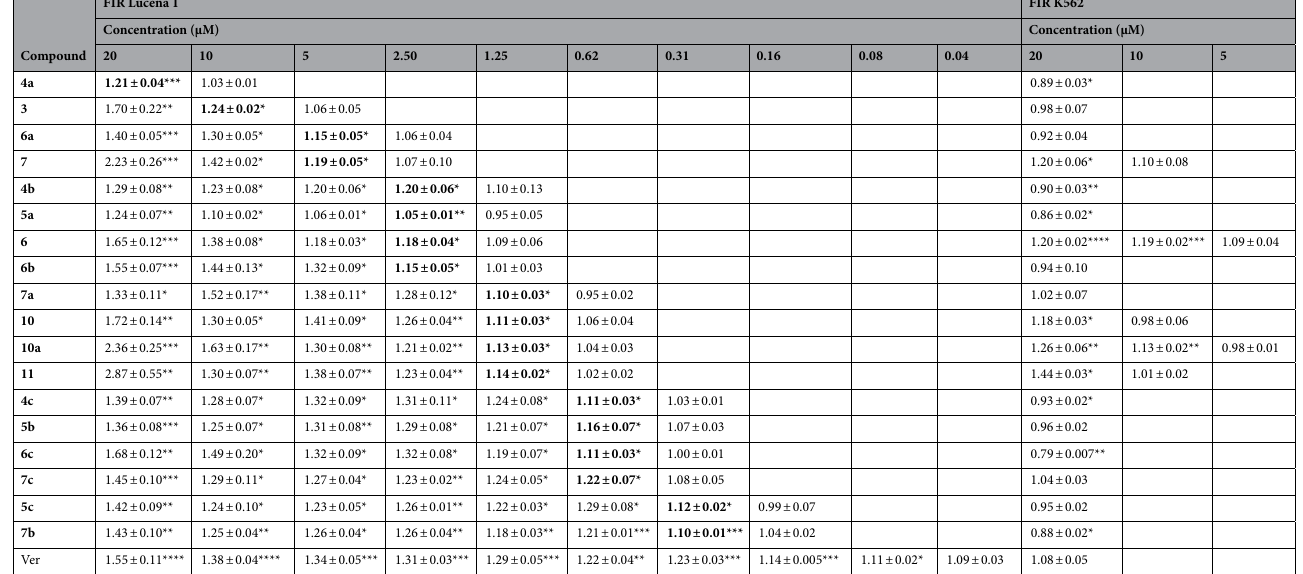
Table 1. Inhibitory effect of target compounds on P-gp transport activity in Lucena 1 and K562 leukemia cells. Fluorescence intensity ratio (FIR) = mean fluorescence intensity (MFI) of doxorubicin (Dox) with compound/ MFI of Dox alone. Ver: verapamil. Significant differences from the negative control were determined by using a paired one-tailed Student’s t test (**** p < 0.0001, *** p < 0.001, ** p < 0.01, * p <